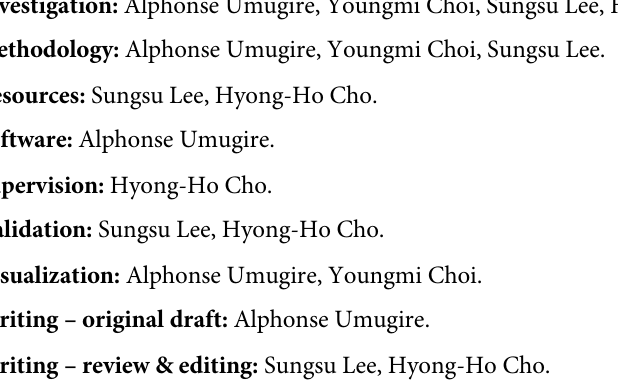
S1 Fig. Methotrexate detection in mouse body fluid by LC-MS. S2 Fig. Wave I ABR amplitude. S3 Fig. ABR click and tone burst. S4 Fig. OHCs counting. S5 Fig. Ribbon counting. (XLSX) S6 Fig. MTT MTX HEI-OC1 cell viability. (XLSX) S7 Fig. AVNC+FA+MTX HEI-OC1 DCFDA. (XLSX) S8 Fig. qPCR